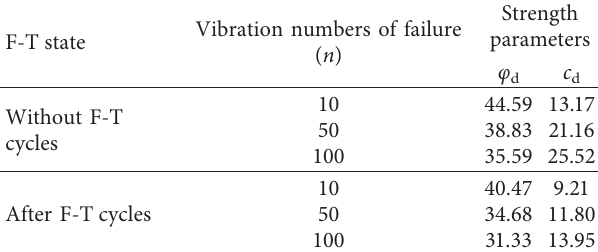
Table 3: Shear strength parameters of test specimens.